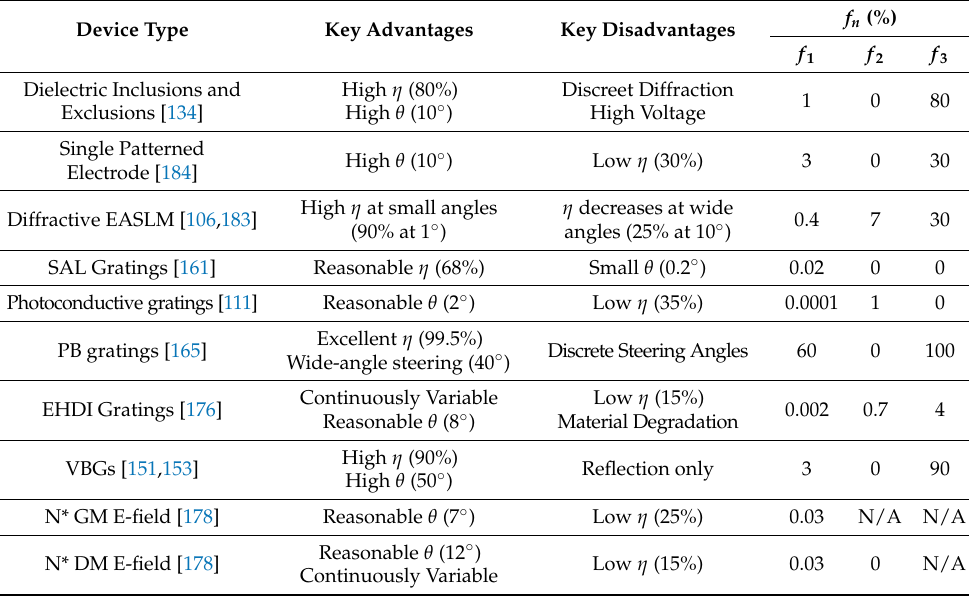
Table 2. Summary of advantages and disadvantages of diffractive